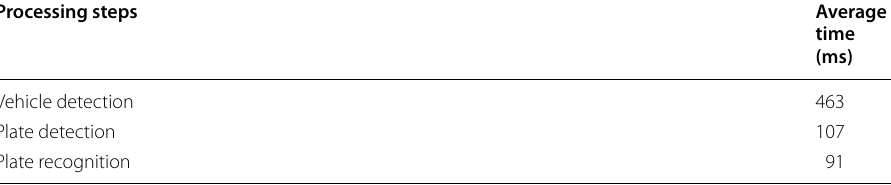
Table 12 Processing time Processing